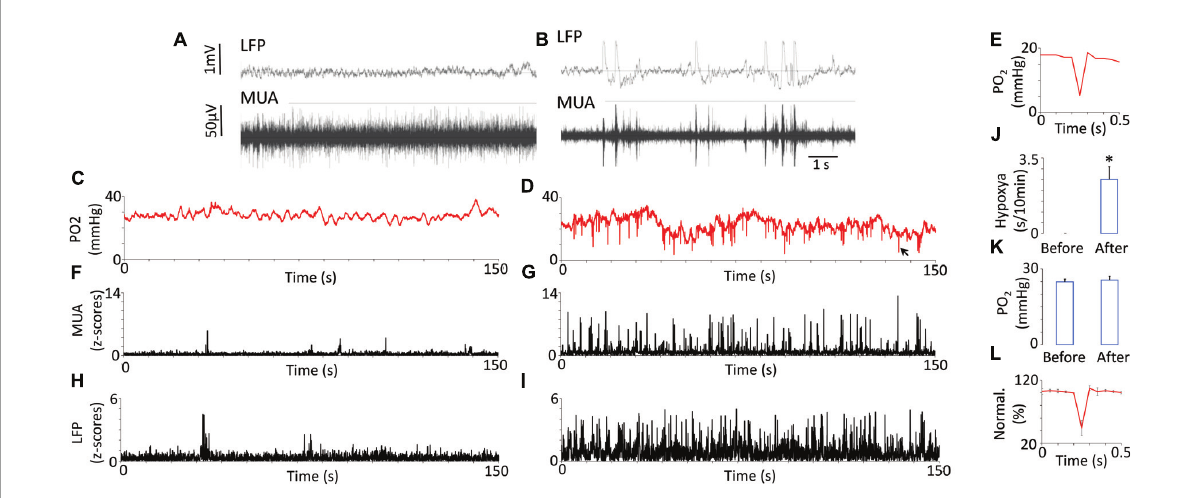
FIGURE1 Oxygen dynamics in response to neuronal synchronization induced by the injection of picrotoxin. Examples of raw recording of multi-unit activity (MUA) and local field potentials (LFP) before (A) and after (B) injection of picrotoxin illustrate electrophysiological characteristics of neuronal synchronization (appearance of rhythmic bursts and near-silent periods between them). Fluctuations of brain tissue oxygen (PO 2 ) before injections were relatively periodical with low magnitude (C) . After the injection the magnitude of PO 2 fluctuations increased and regular dips below 10 mmHg appeared (D) . Sometimes the dips reached even 5 mmHg while having duration less then 100 ms (E) . The black arrow indicates the dip on D which is presented on panel (E) . MUA before injection did not have any regular bursts (F) but after injection the bursts appeared (G) . LFP before (H) and after injection (I) generally followed the behavior of MUA. Note that dips in PO 2 appeared together with bursts on MUA or LFP. The total duration of hypoxia reached 2 s over 10 min (J) . The averaged baseline of PO 2 did not change after the injection ( N = 7) (K) . The error bars represent standard error. The overshoot after the dip is shown on the population data (L) . The data was normalized to 100% of the point before the dip. Error bars represent standard deviation for better visibility. Asterisk represents a significant difference ( p <